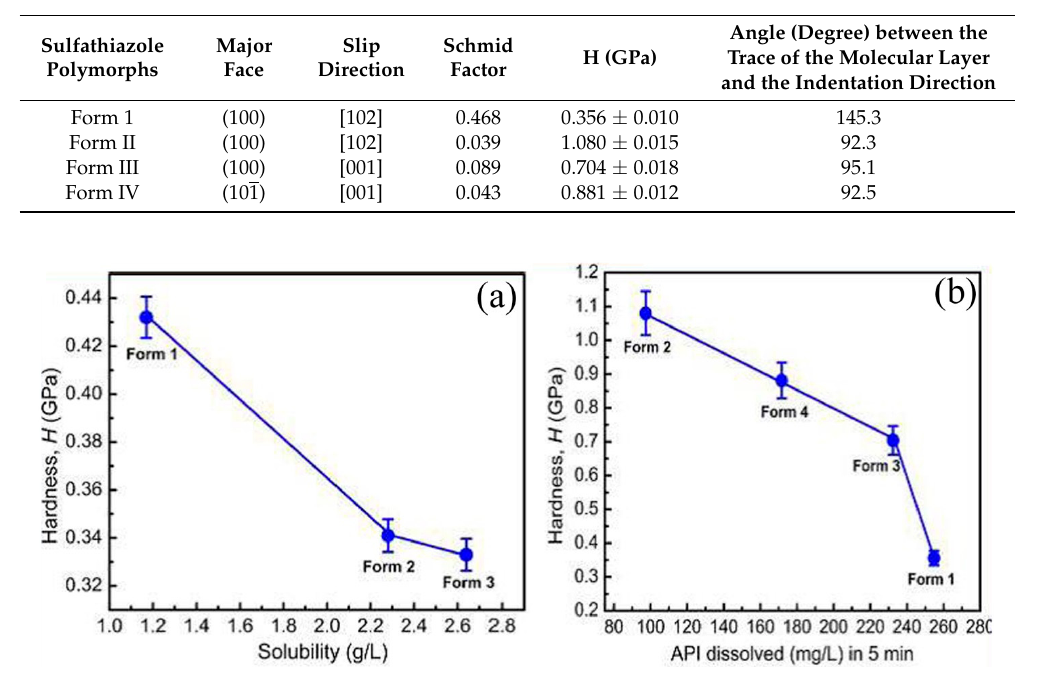
Figure 14. An inverse correlation of hardness and solubility in ( a ) curcumin and ( b ) sulfathiazole polymorphs. (Reproduced with permission from the American Chemical Society, Reference 99).